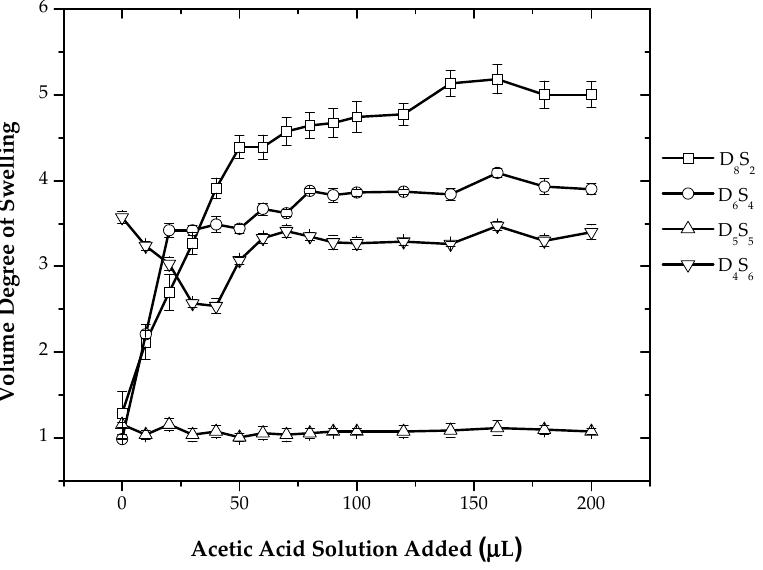
Figure 6. Variation of the volume degree swelling with the addition of acetic acid for System III.